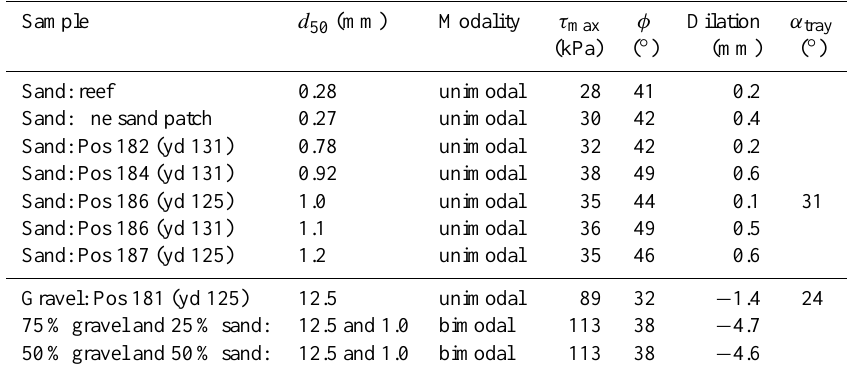
Table 1. Summary of sediment properties and shear test result terms of median grain size d 50 , modality (unimodal vs. bimodal), maximum shear stress measured for the highest load level of the respective sample in the direct shear boxes τ max , internal angle of friction φ max , maximum observed vertical displacement during shearing in the respective direct shear box (dilation is positive) and tray tilt angle when sediment started moving α tray